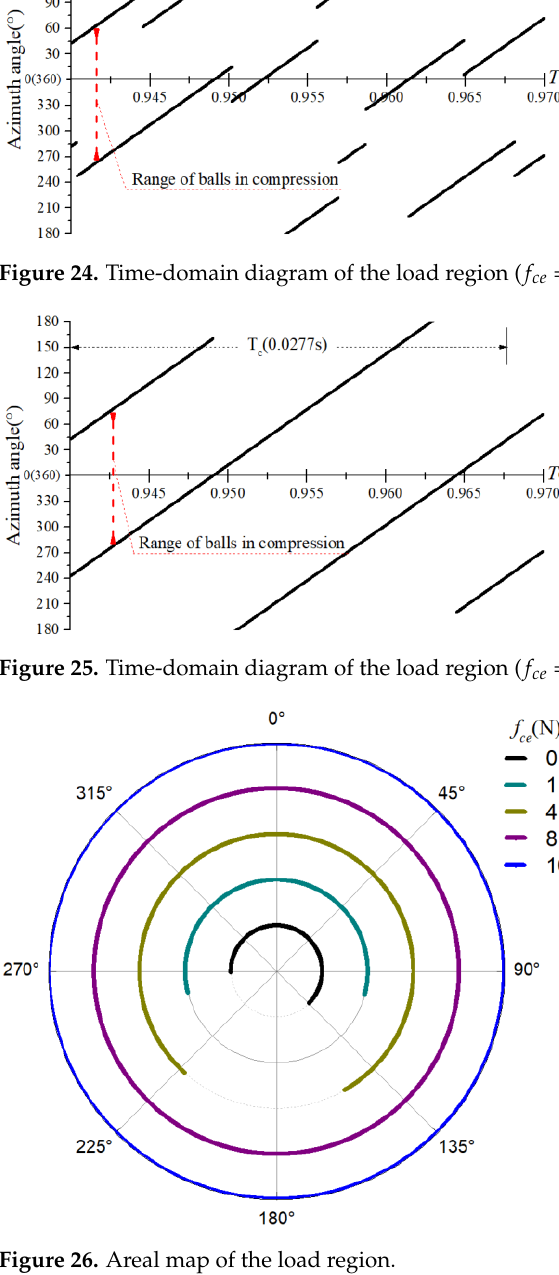
Figure 26. Areal map of the load region.